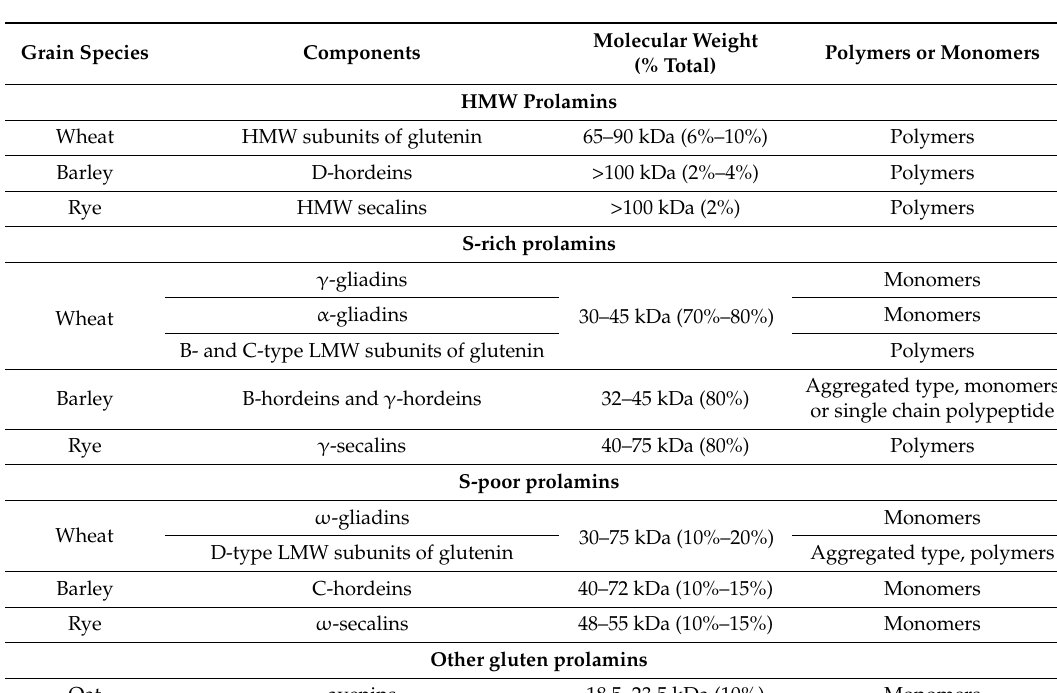
Figure 2. Prolamin Superfamily composition. Table 2. Classification of gluten prolamins.